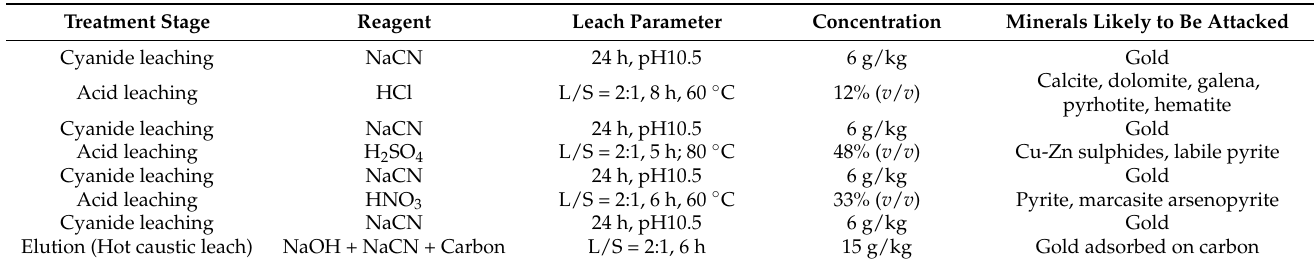
Table 2. Diagnostic leaching